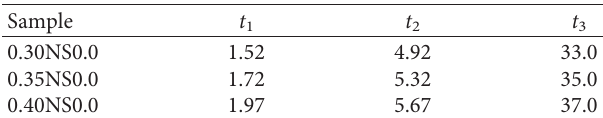
2 signal. Figure 4: Effects of different w/c on the hydration Table 4: The hydration period separation time of different w/c pastes (h).